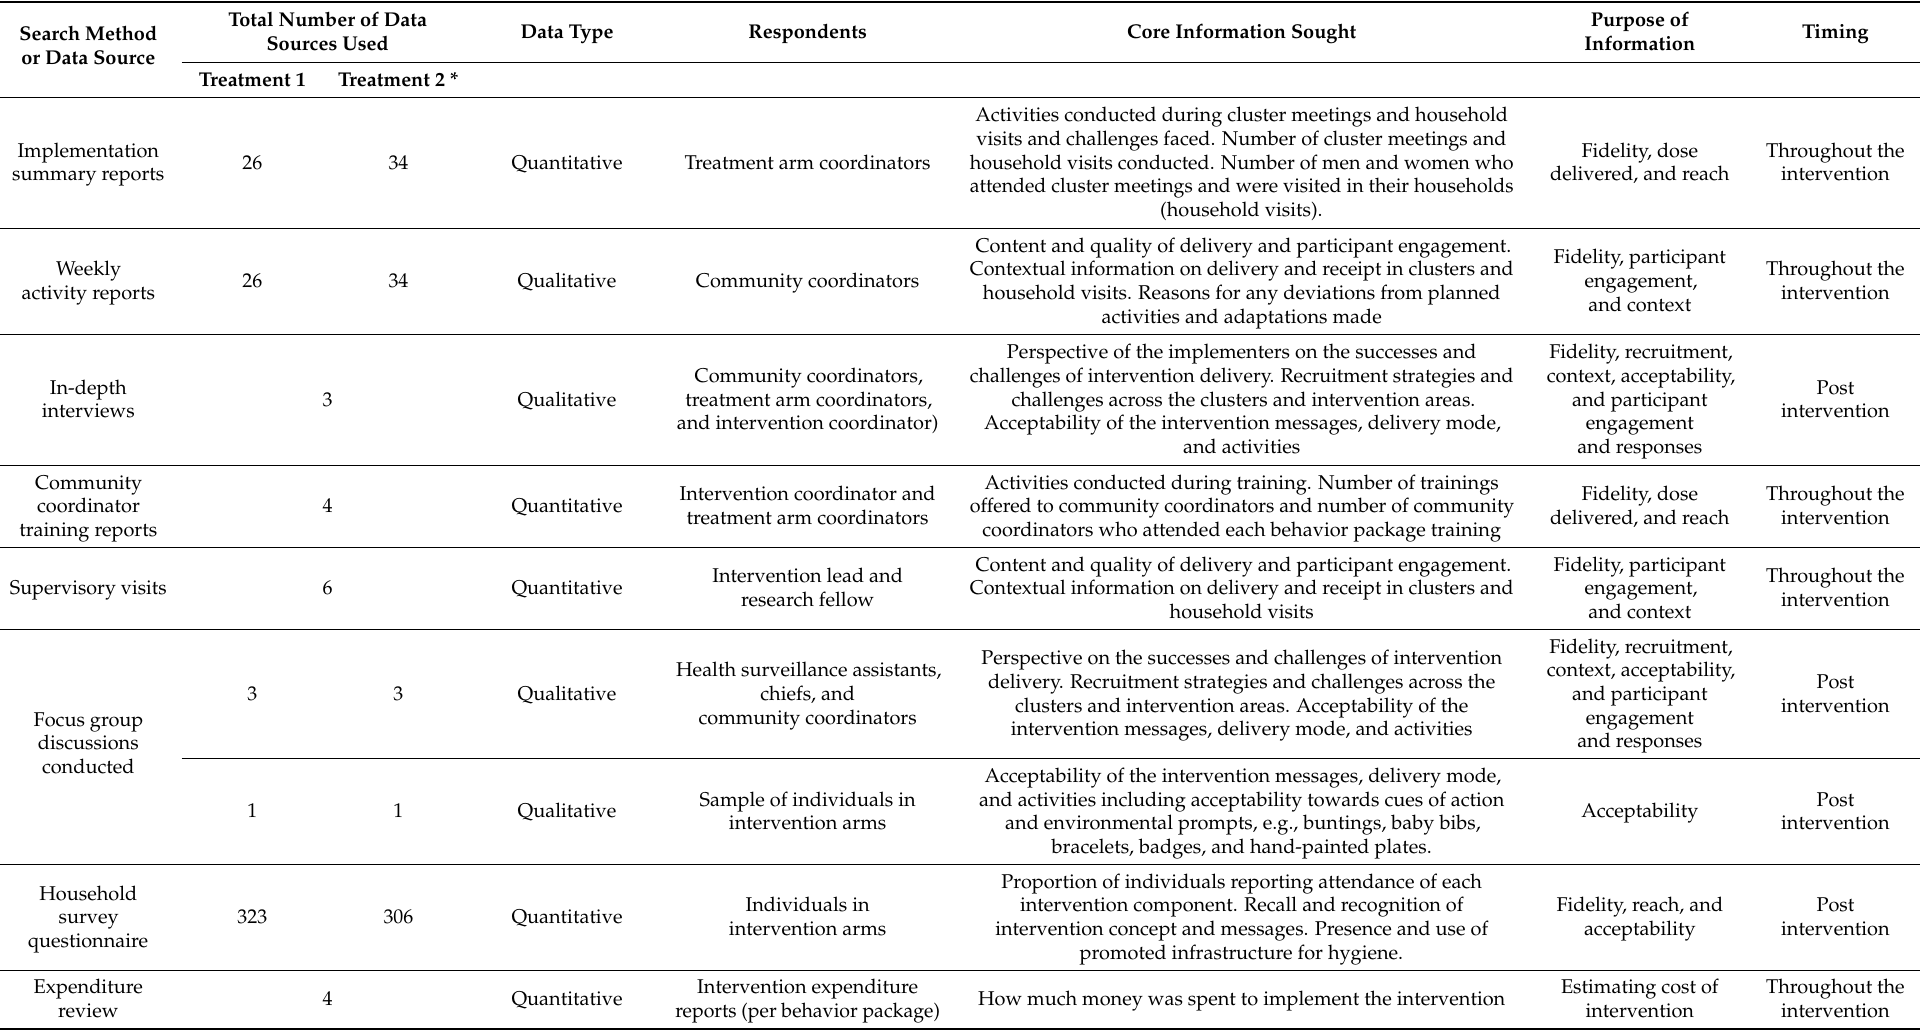
Table 1. Overview of Process Evaluation